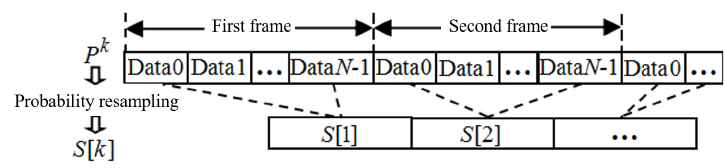
Figure 5. Frame format.